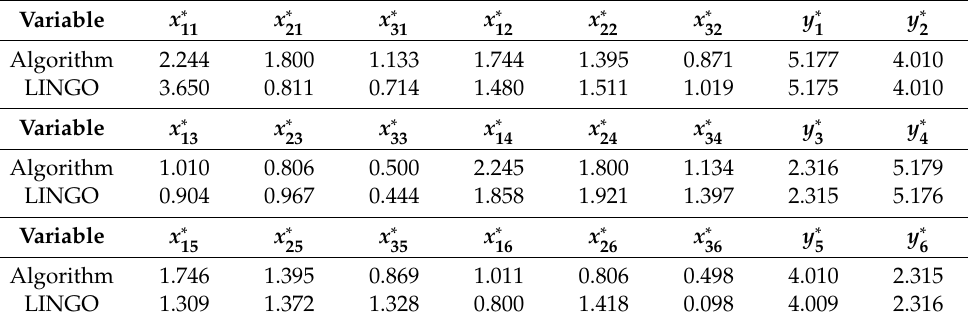
Table 3. The optimal allocation of the bandwidth resources for customer r.